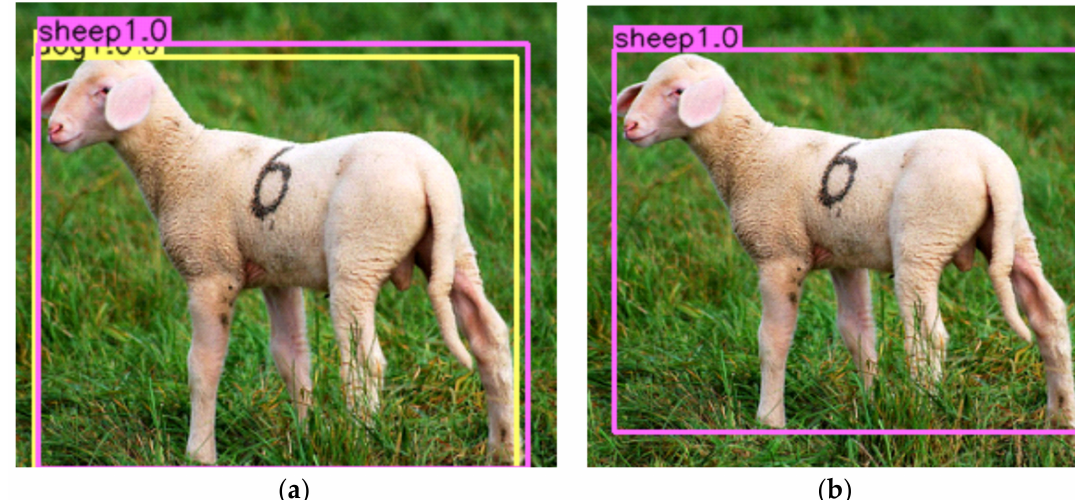
Figure 5. The GT’ problems and solutions: ( a ) Labeling of GT’; ( b ) the result of IoU > 0.8